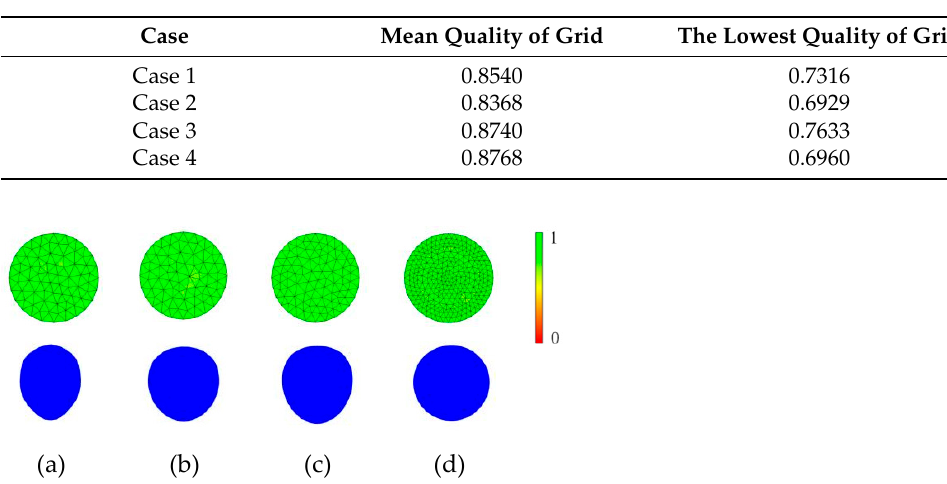
Figure 1. The geometric sketch of water droplet in an air pipe.